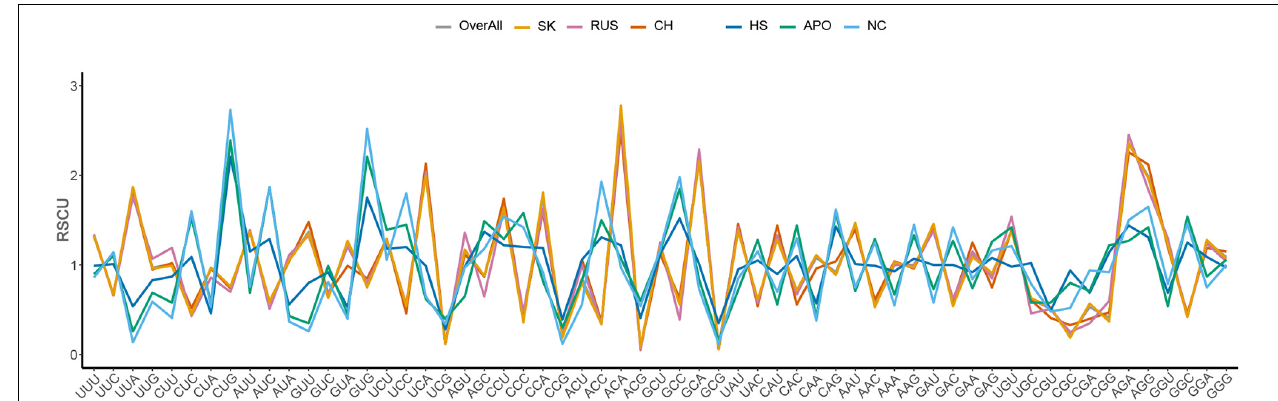
FIGURE 1 | Comparative analysis of RSCU patterns between Hantaan virus (HTNV), clades, host, and natural reservoirs.